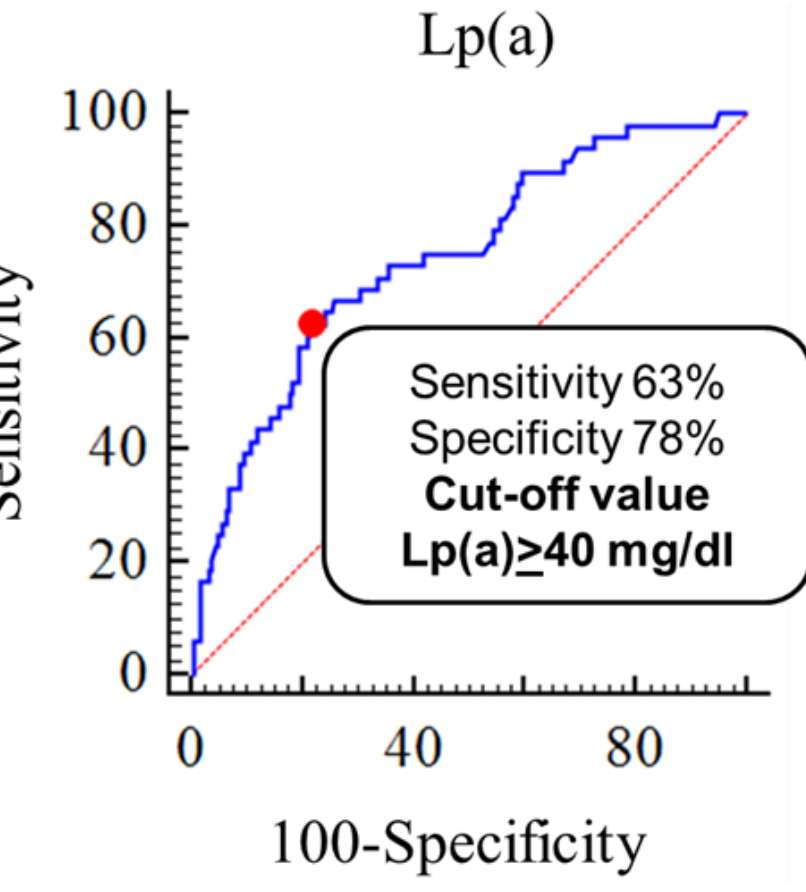
Figure 4. Threshold lipoprotein(a) level associated with heterozygous familial hypercholesterolemia